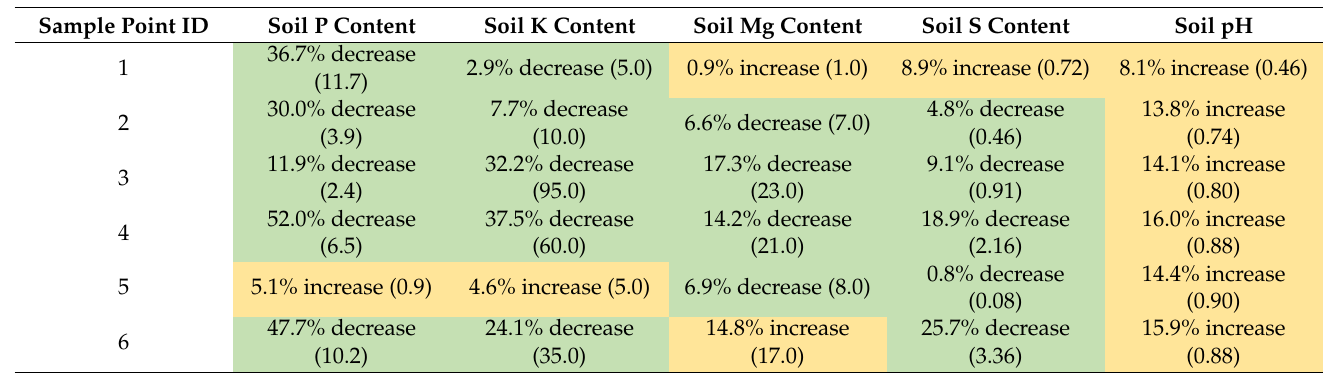
Table 2. Calculated percentage change in soil nutrient content (mg L − 1 ) and soil pH from 2020 to 2021 per gridded sample point. Absolute value change from 2020 to 2021 is given in brackets. Green (yellow) coloured cells indicate a decrease (increase) in nutrient content from 2020 to